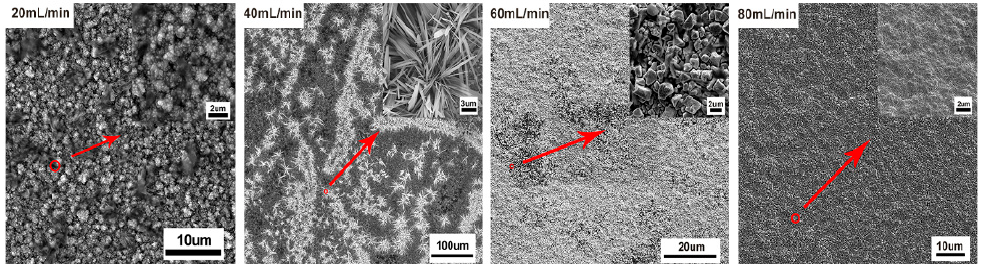
Figure 7. SEM images of copper thin films formed under different flow rates.